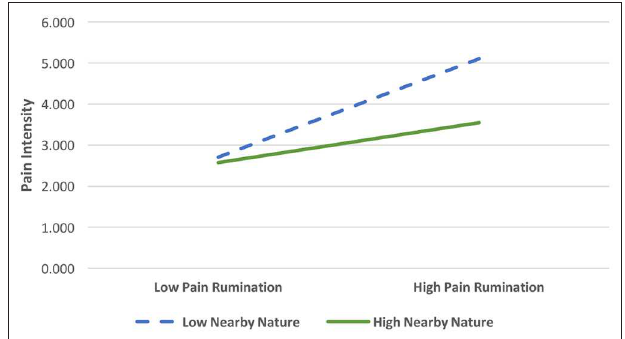
FIGURE 5 | Relationship between pain rumination and pain intensity as a function of nearby nature. High and low values were defined as one standard deviation from the